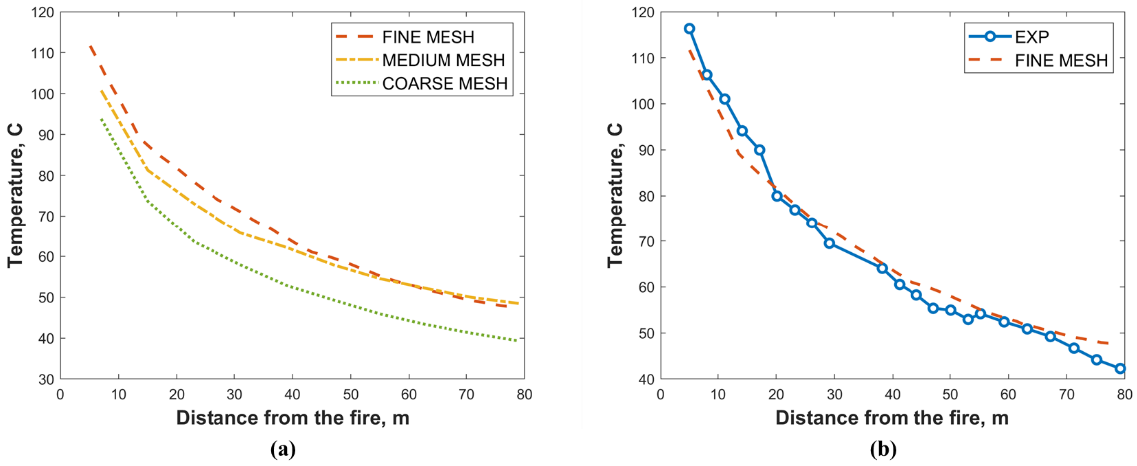
Figure 4. ( a ) Mesh sensitivity study using the gas temperature profile and ( b ) gas temperature pro- file comparison between experimental and numerical predictions along the long channel for the 0.75 MW diesel pool fire case.